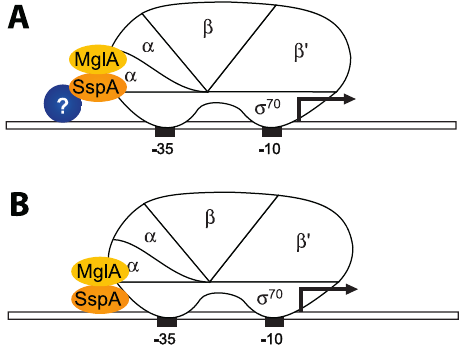
Figure 6. Models for How the MglA–SspA Complex Positively Controls Virulence Gene Expression in F. tularensis (A) Contact between a DNA-bound transcription activator and the RNAP- associated MglA–SspA complex activates transcription from a virulence gene promoter. The arrow indicates the transcription start site. (B) Contact between promoter DNA and the RNAP-associated MglA– SspA complex activates transcription from a virulence gene promoter. In these models, the virulence gene promoters are depicted as being recognized by RNAP holoenzyme containing r 70 . The RNAP that co- purifies with MglA-TAP appears to contain r 70 in stoichiometric amounts (Figure 1B), suggesting that the promoters of MglA/SspA-dependent genes may be r 70